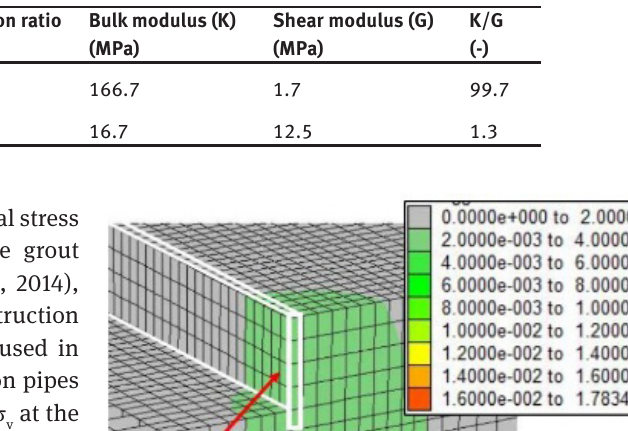
Table 3: The properties of grout in modeling.